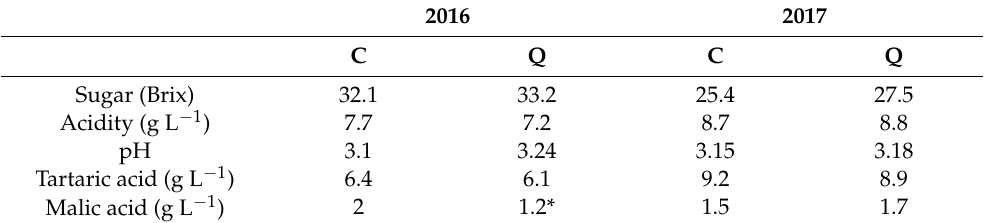
Table 2. Wine must parameters after the withering process, in C (Colombara) and Q (Quaiara). Within rows, *; **; *** values are different at α ≤ 0.05, 0.01, and 0.001. Contents are expressed as mg Kg − 1 .